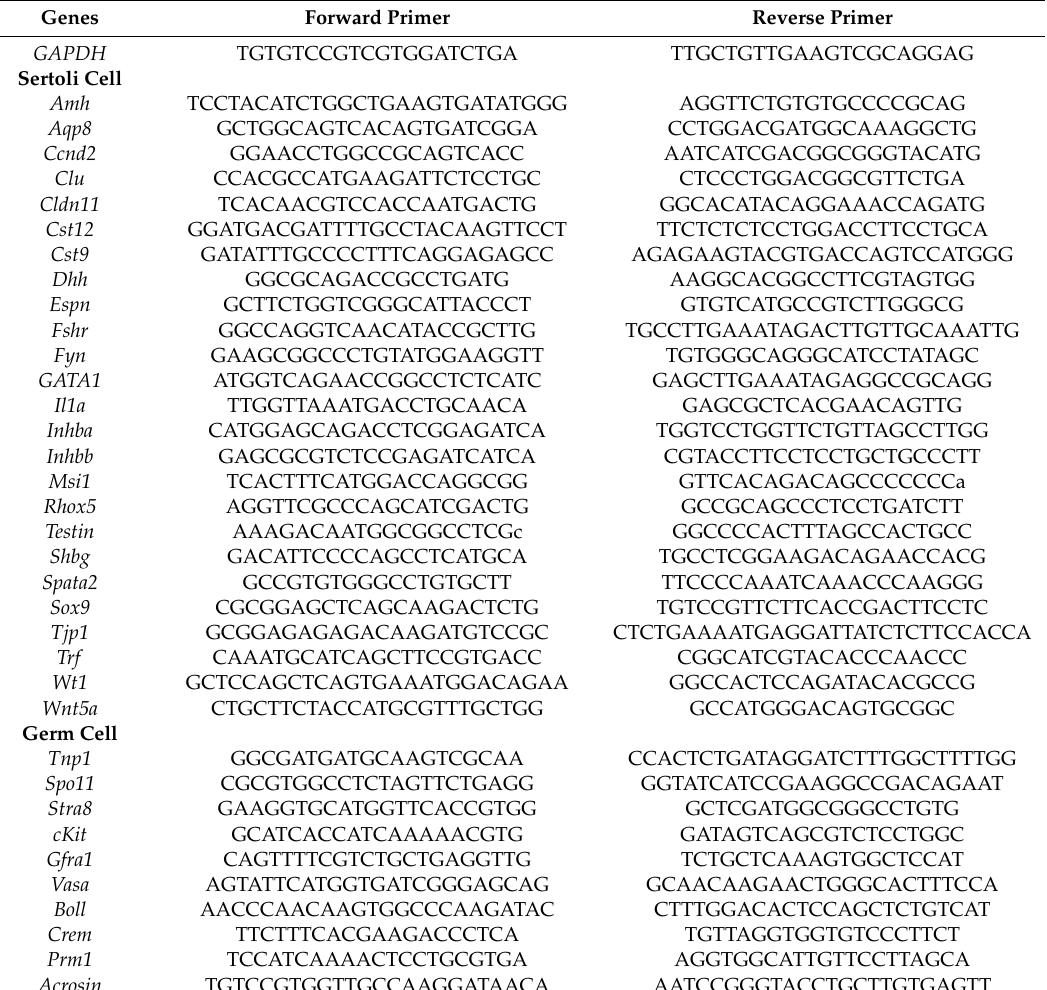
Table 1. Primers used for real-time